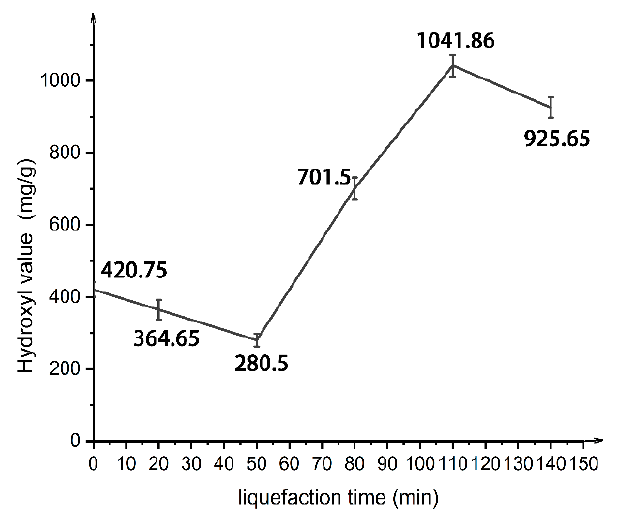
Figure 7. Hydroxyl value of liquefied products at different liquefaction times.